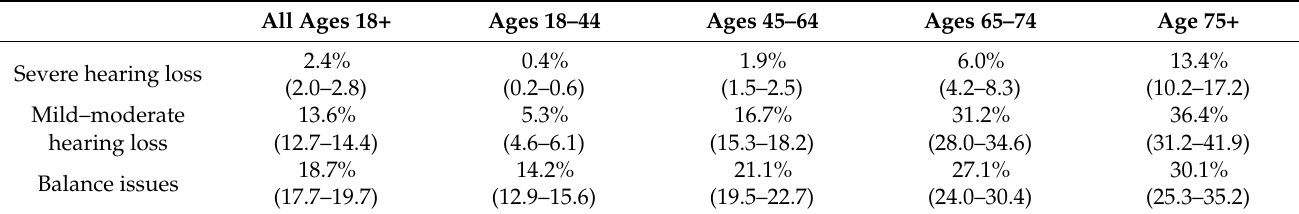
Table 1. Hearing loss data based on National Health Statistics Reports 2020